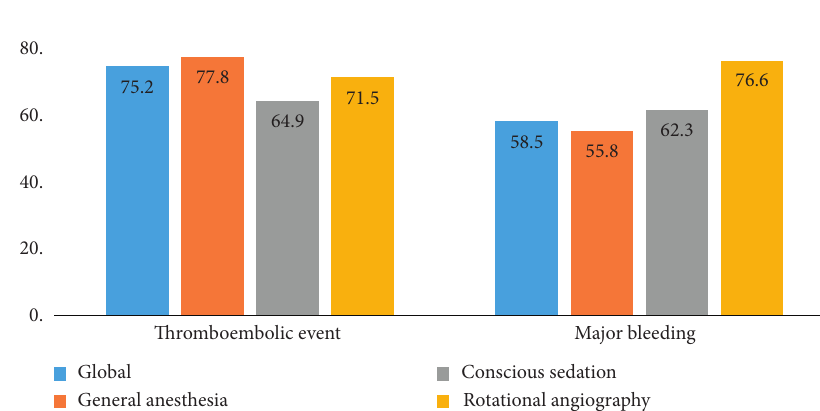
Figure 2: Relative risk reduction (percentage) for thromboembolic events (ischemic stroke/systemic embolism) and for major bleeding in global population and for each LAAC